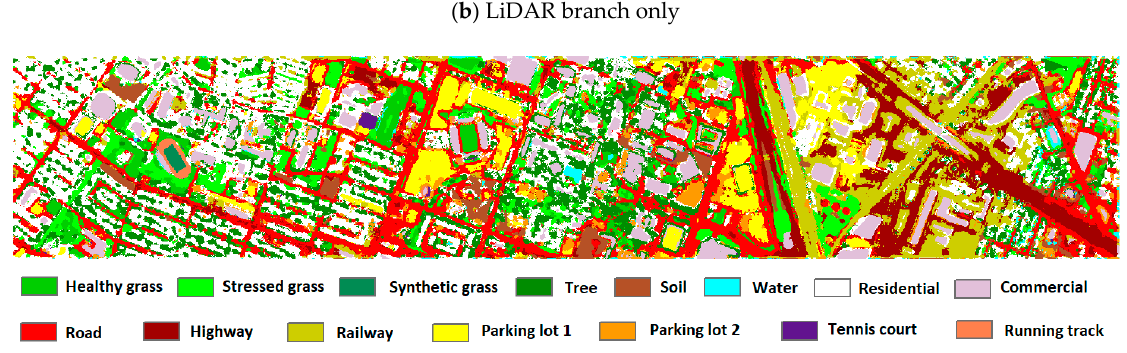
Figure 7. Classification maps for ( a ) HSI branch only; ( b ) LiDAR branch only; ( c ) proposed two-branch CNN.